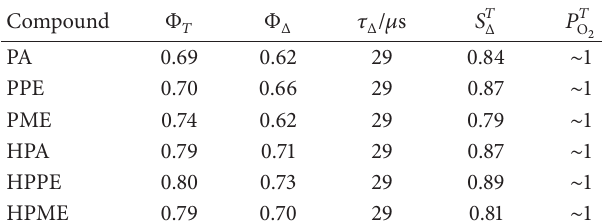
Table 2: Summary of the parameter relative to the singlet oxygen quantum yield.